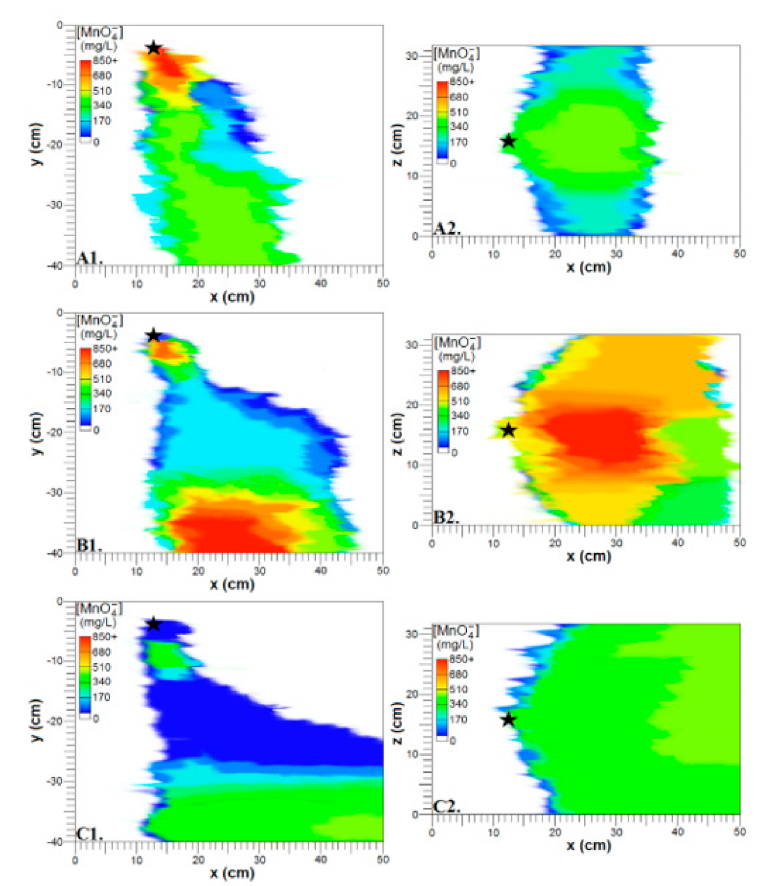
Figure 7. Estimation of MnO 4 − migration. ( A1 ) Extent of sinking and forward migration based on [MnO 4 − ] measurements from central monitoring wells; ( A2 ) Extent of lateral dispersion and forward migration based on [MnO 4 − ] from wells at a depth of 38 cm 18 h after injection; ( B1 ) Extent of sinking; ( B2 ) Lateral dispersion, and migration 54 h after injection; ( C1 ) Extent of sinking; ( C2 ) Lateral dispersion, and migration 7 d after injection. Maps were created in Corel Paintshop Pro X7 by matching well measurements to their respective locations and estimating [MnO 4 − ] in the space between wells ( (cid:70) = Injection